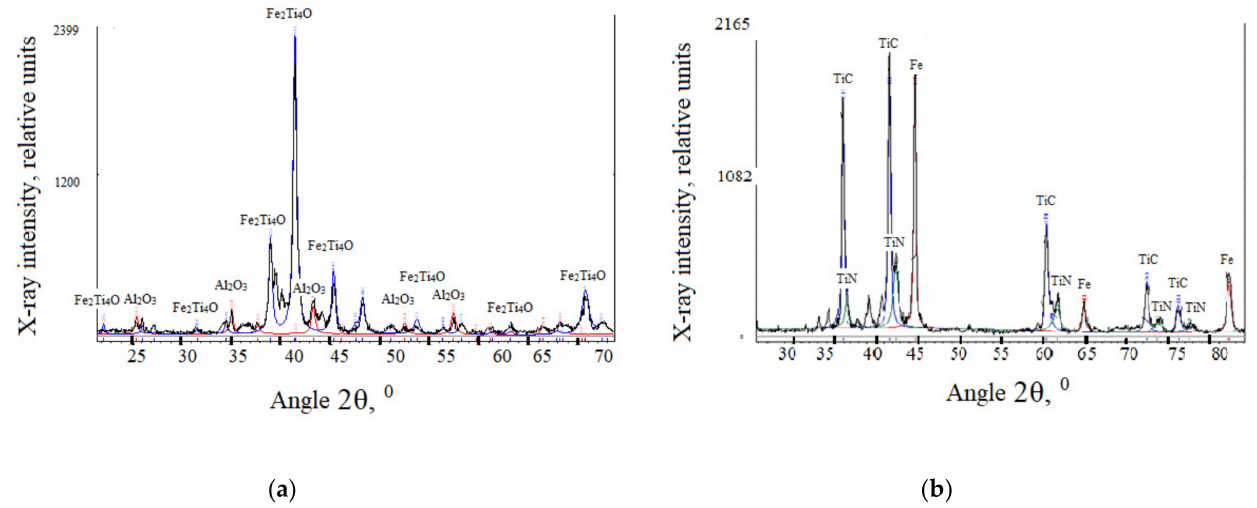
Figure 2. Diffractograms for AISI W1-7 steel with TiN-(PVD) layer after titanium aluminizing: ( a ) surface; ( b ) at a depth of 10 µ m of the cut layer. Radiation Cu K α 1, λ = 0.154